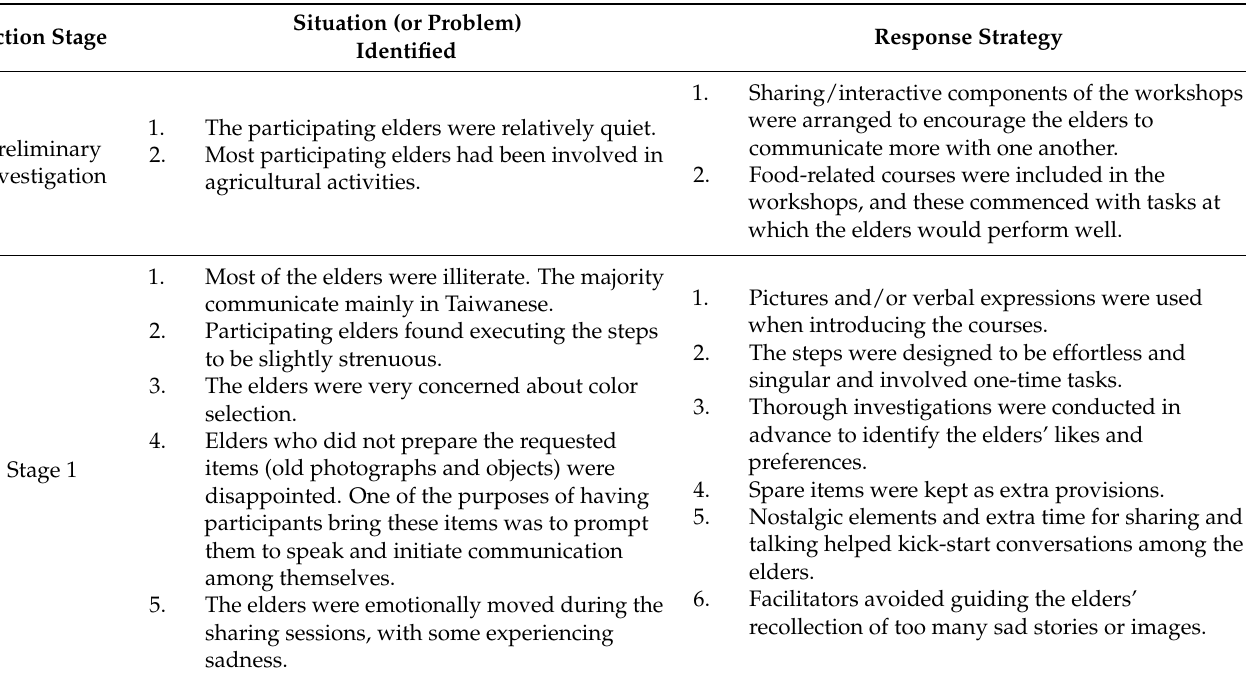
Table 3. Records of Problems Identified at Each Stage of the Action Research and Corresponding